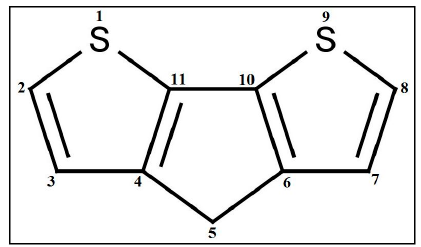
Figure 5. Fragment defines D/Dtr11 descriptor.